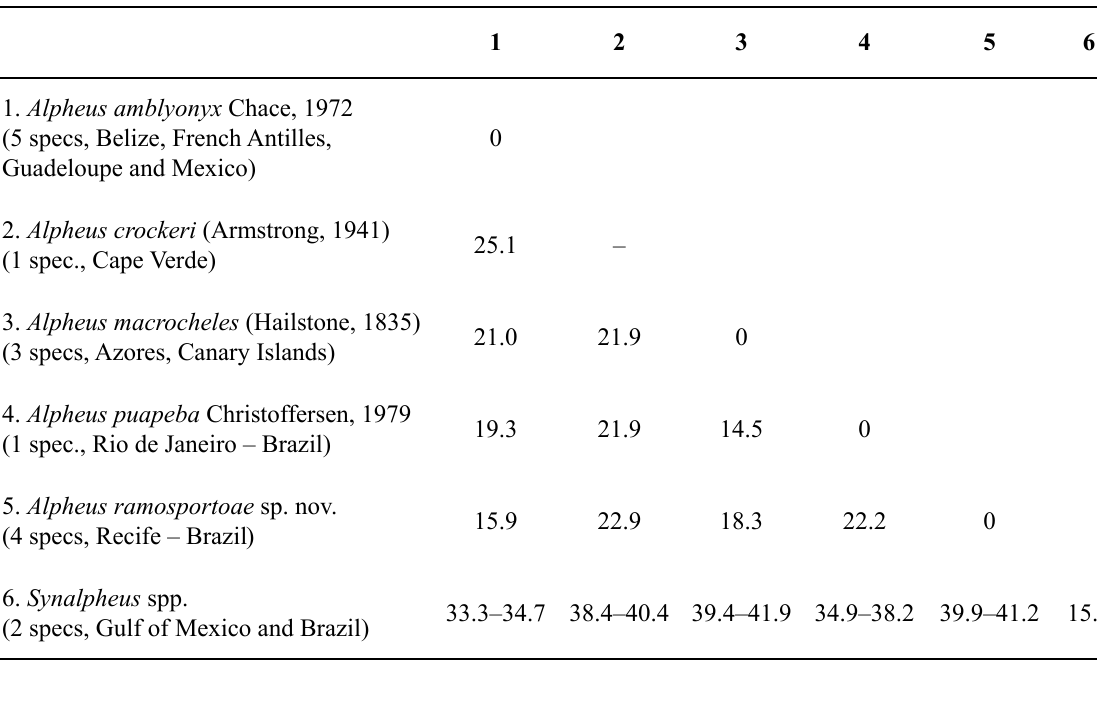
Table 2. Genetic distance matrix of the 16S gene between Alpheus ramosportoae sp. nov. and some selected species assigned to the A. macrocheles species complex, as well as Synalpheus C.S. Bate, 1888, built with the TPM3 model. The number of specimens used in the analysis for each taxon is presented along with the collection